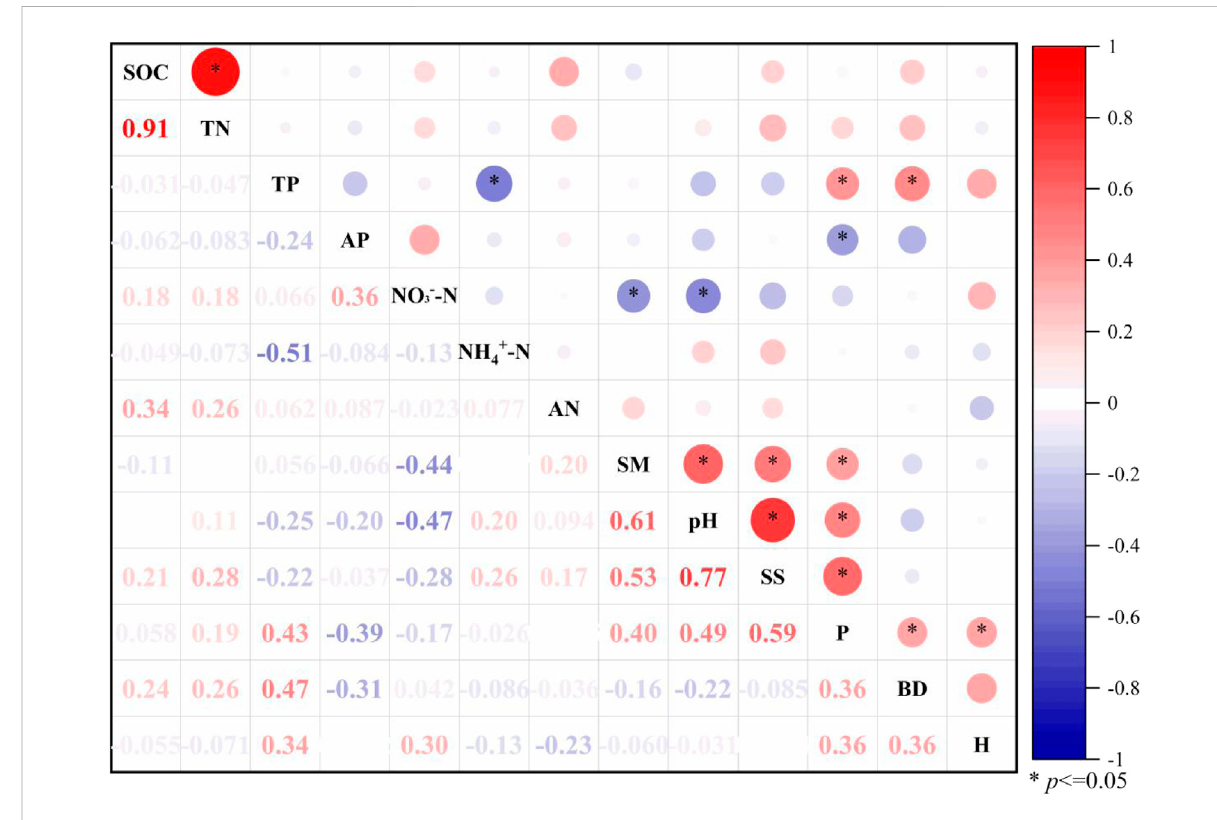
FIGURE 3 Correlation analysis of in fl uencing factors of the ‘ fertilizer island ’ effect of different nutrient contents in Nitraria tangutorum . Note: BD, base diameter.